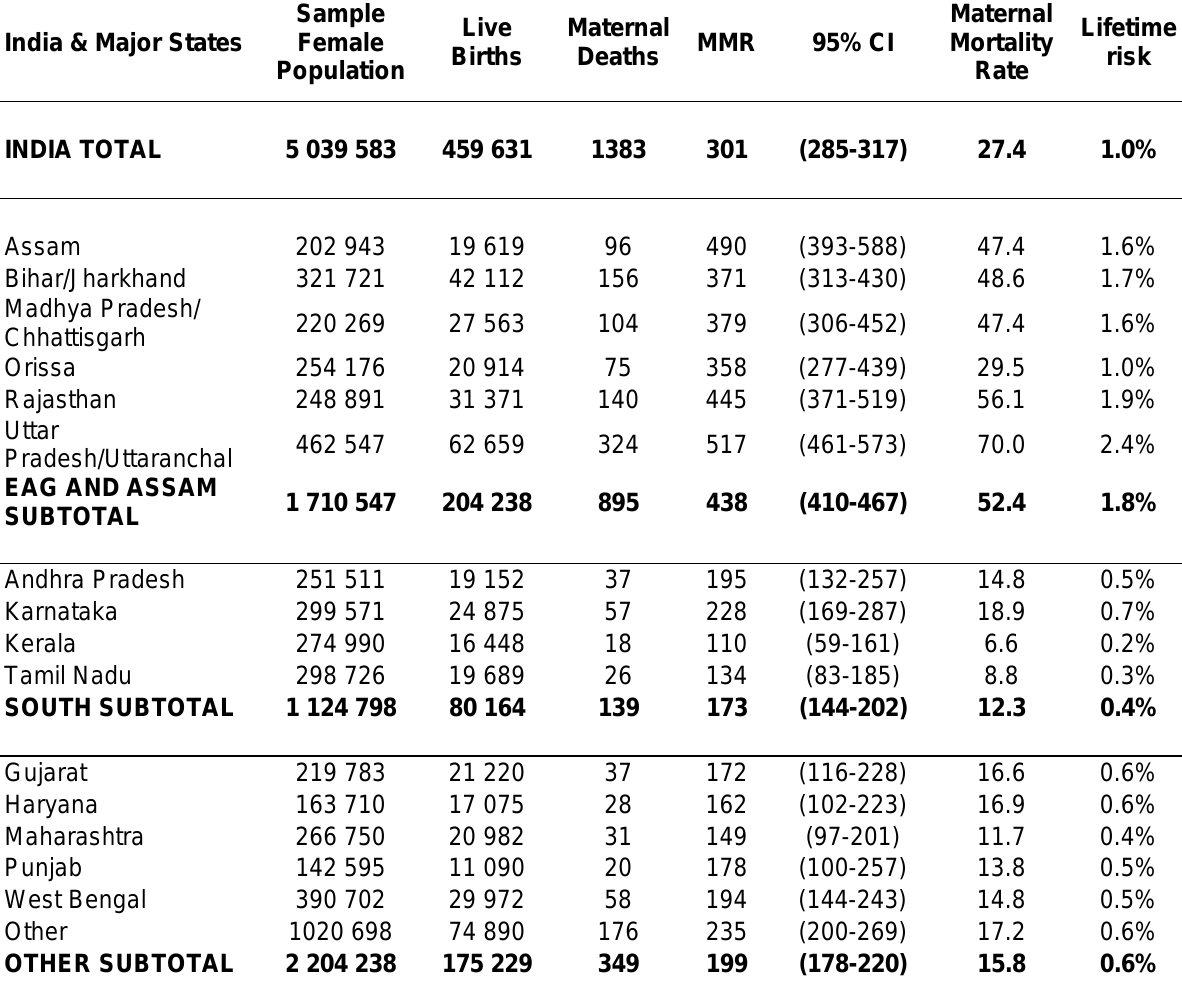
Table 3: Live Births, Maternal Deaths, Maternal Mortality Ratio in India by State from 2001-2003 Special Survey of Deaths using RHIME India & Major States